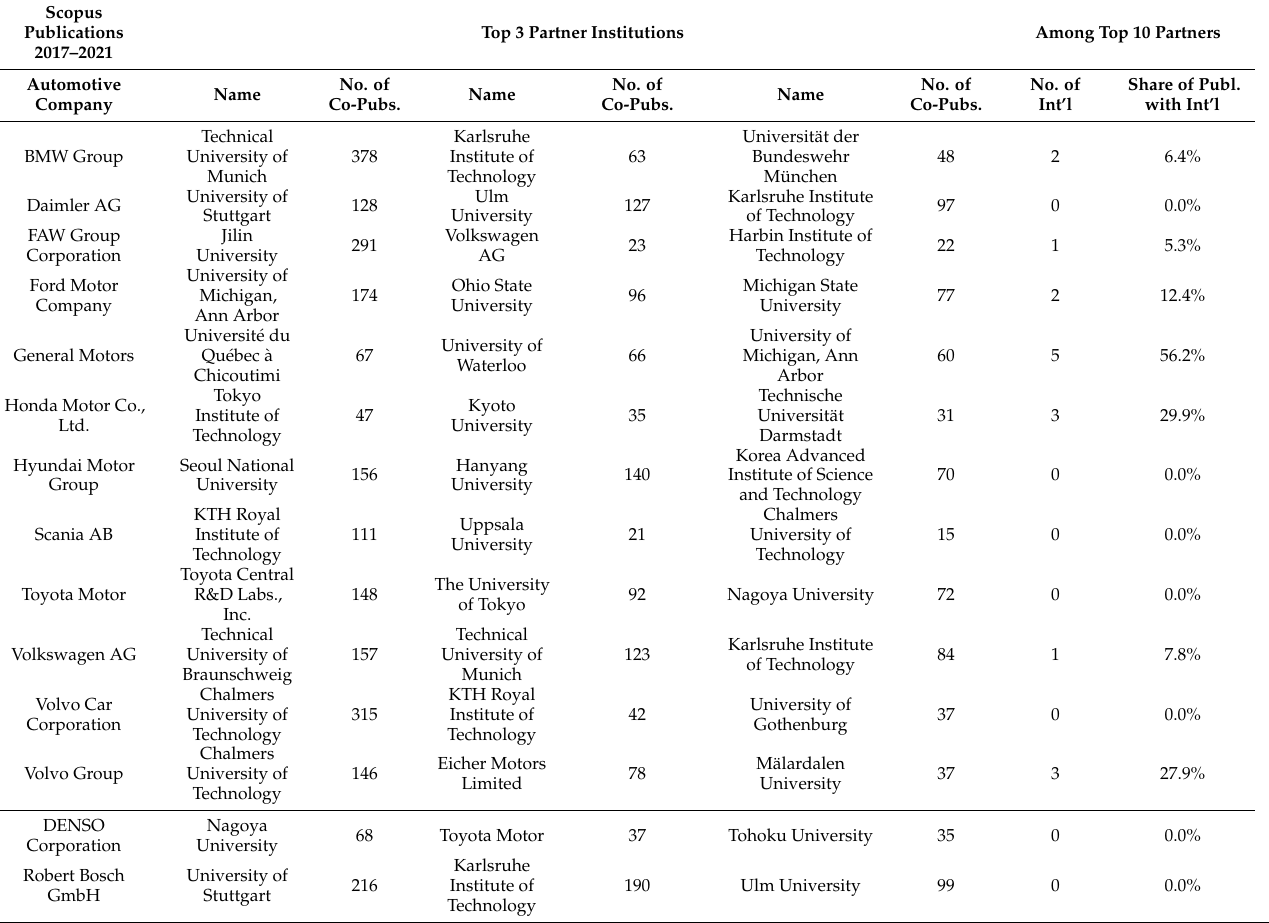
Table 7. International partners among the top ten